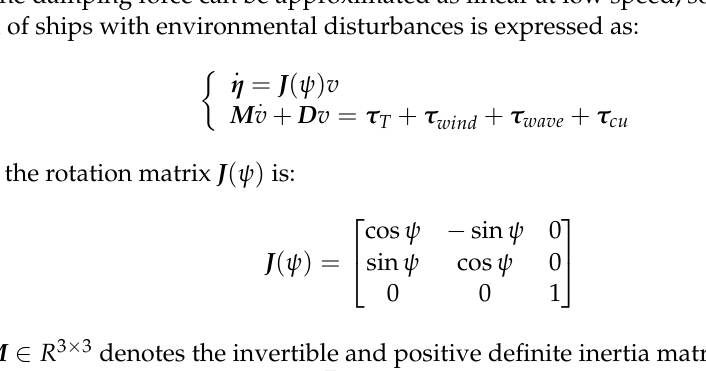
Figure 1. Coordinate definition in horizontal planes.